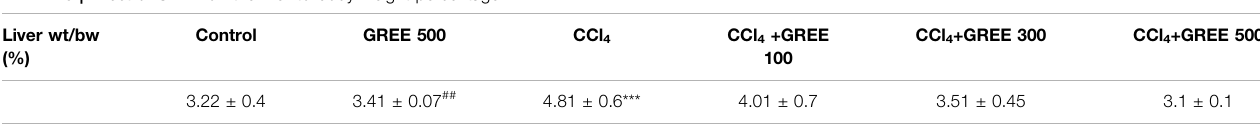
TABLE 6 | Effect of GREE on the liver-to-body weight percentage.